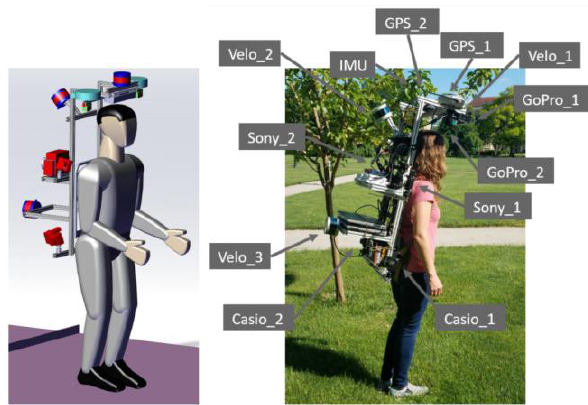
Figure 3. System design: project created using CAD software (left) and ready prototype (right)